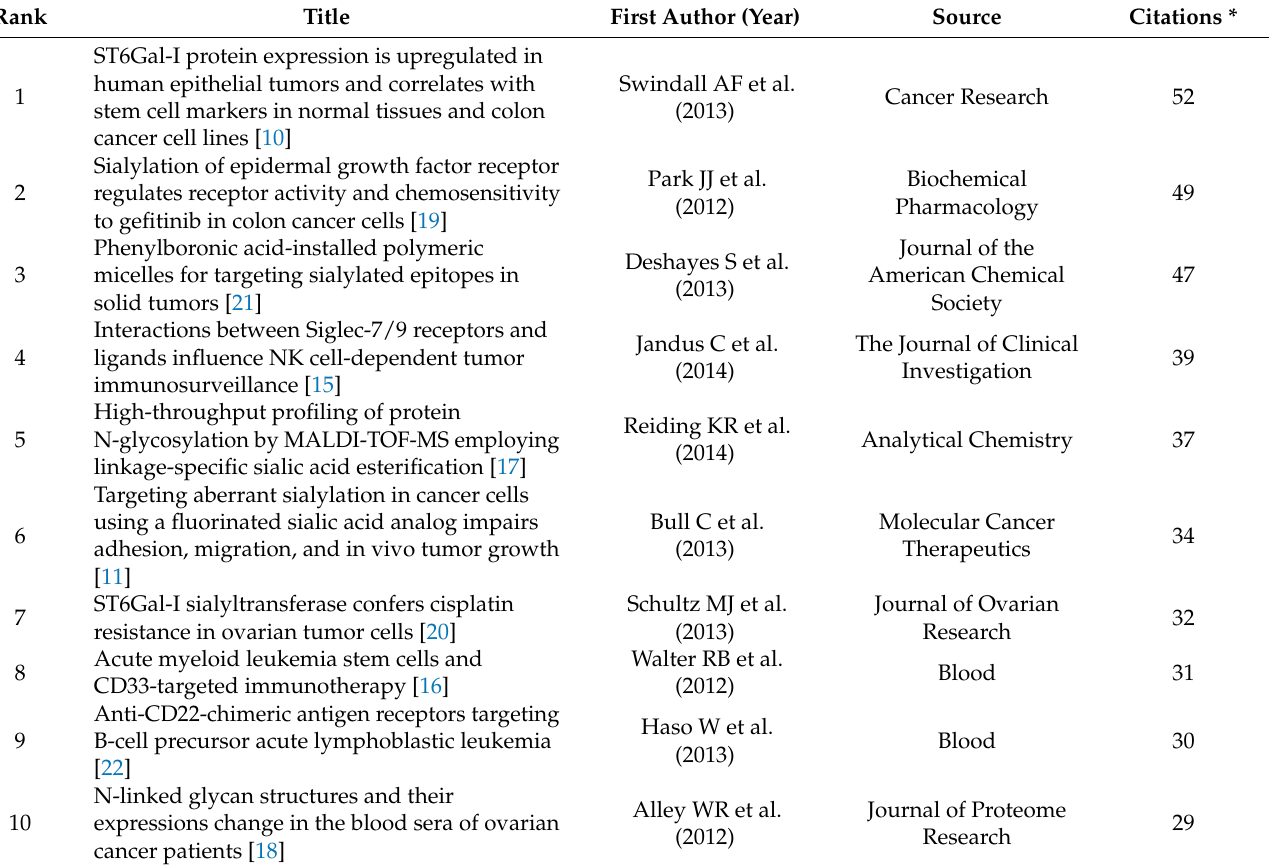
Table 1. Top 10 articles with the highest citations of cancer sialylation